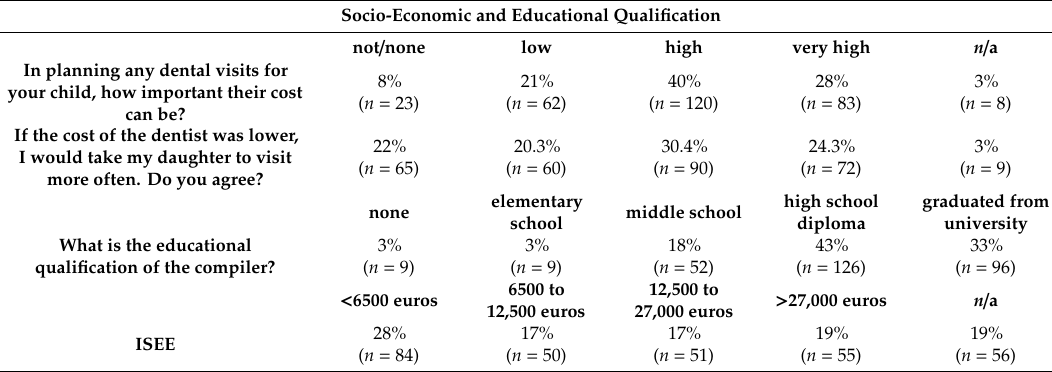
Table 4. Questions and data on socio-economic and educational